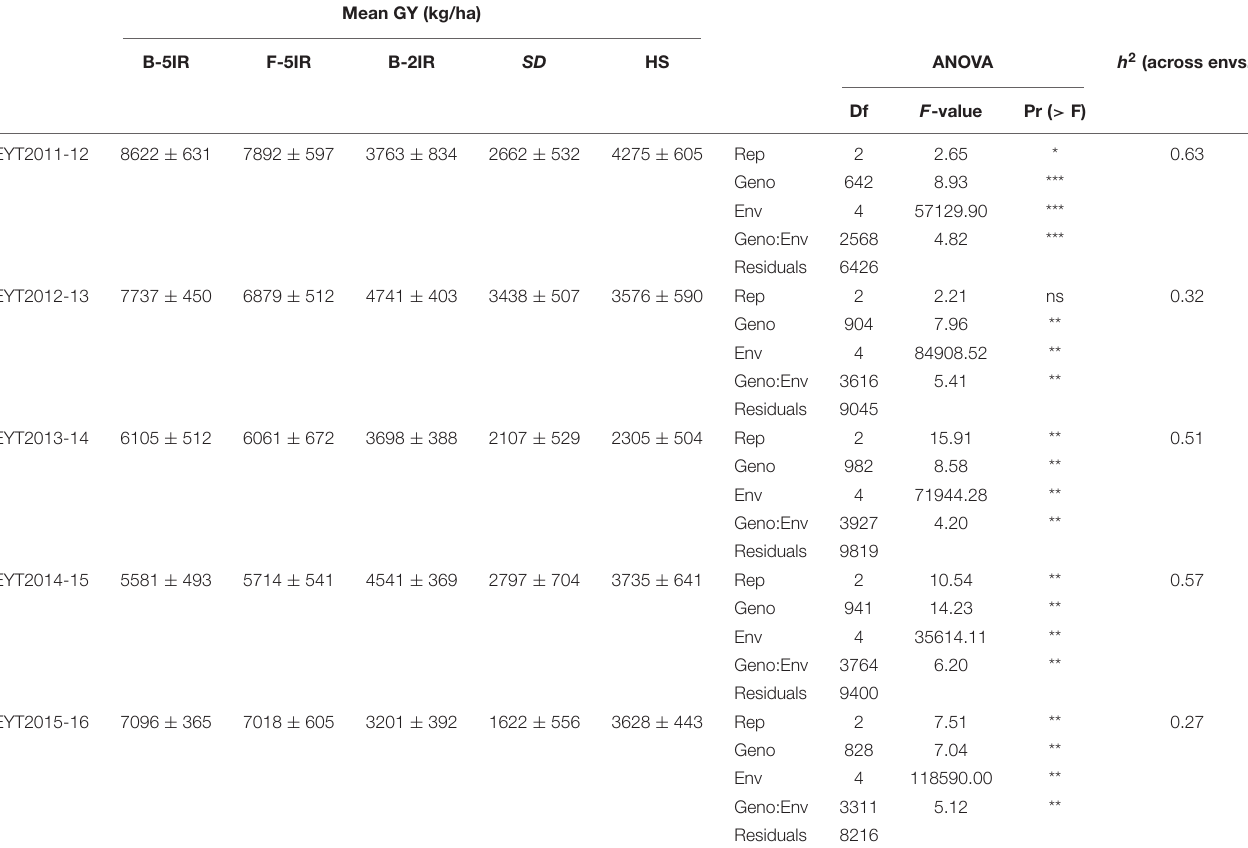
TABLE 1 | Adjusted mean of GY, ANOVA and heritability ( h 2 ) of the five elite yield trials (EYT). Mean GY (kg/ha) B-5IR F-5IR